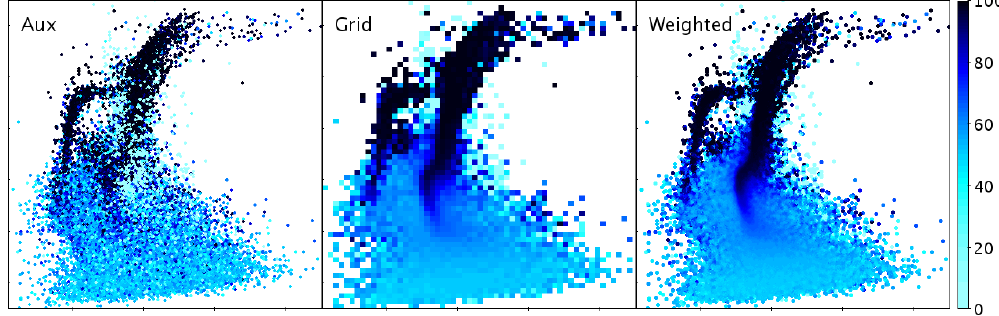
Figure 5. Various representations of a 2-dimensional point cloud with a third dimension indicated by colour. Aux paints opaque coloured markers, which works for low-density regions, but at high density the appearance is noisy and depends on row sequence, since points painted later obscure earlier ones. Grid is a 2-d histogram weighted by the third coordinate; points in the same bin are averaged, but some spatial resolution is lost. Weighted is a hybrid density map/scatter plot but with pixel bins weighted by the third coordinate, providing clarity in both low and high density regions. The weighting combination method in the latter two cases is configurable; in this case the median has been used. Data are as for Figure 4 with the third coordinate indicating probability of cluster